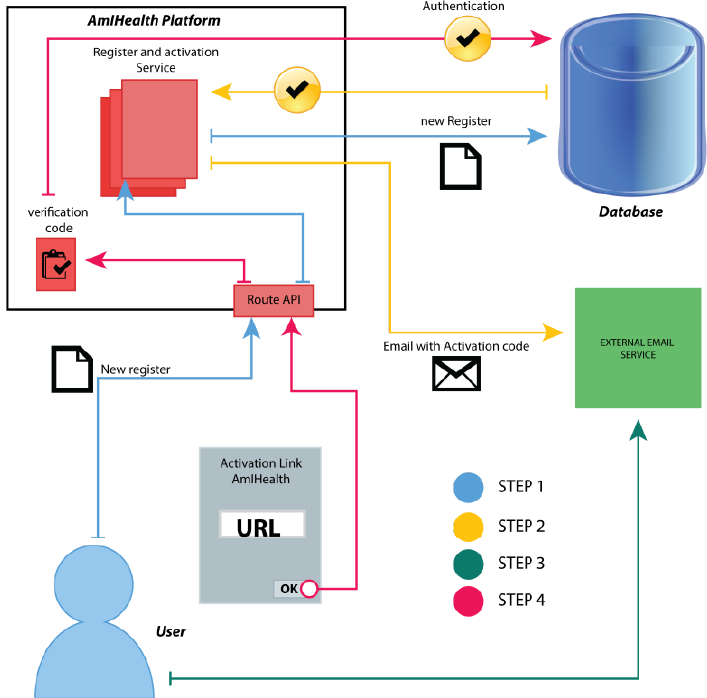
Figure 3. Authentication and authorization process.